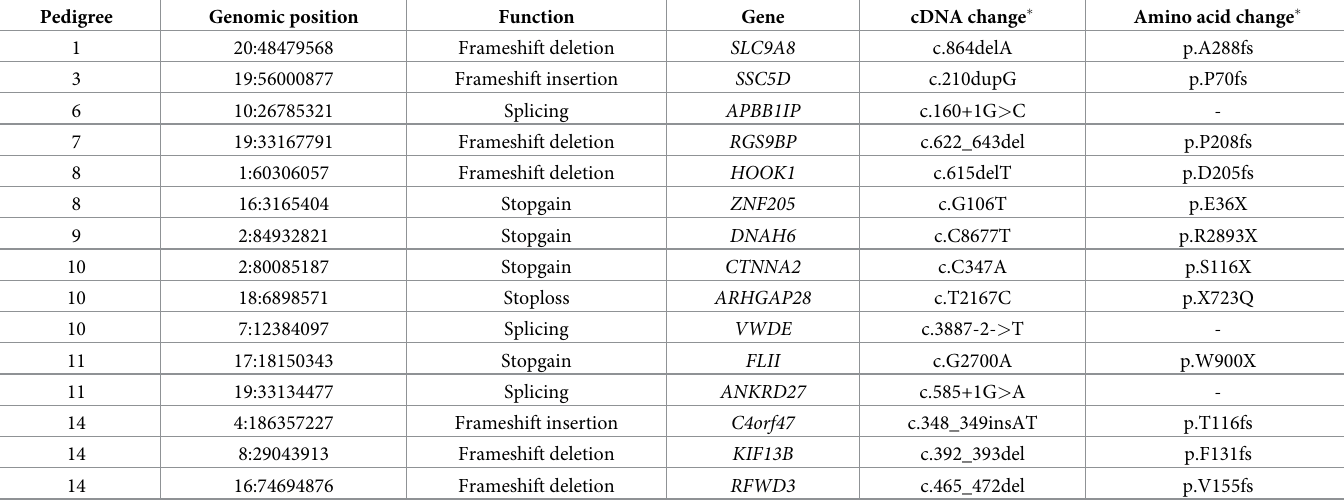
Table 1. Loss-of-function variants.